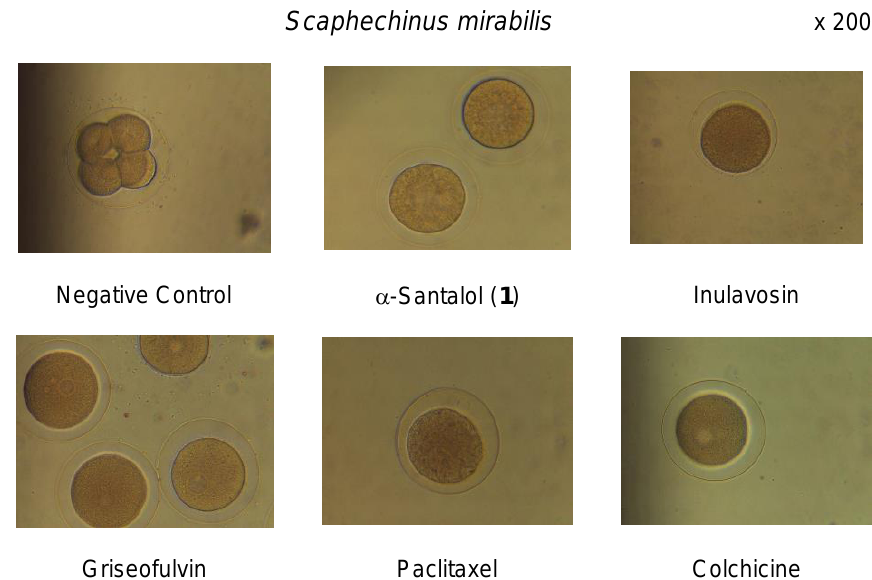
Figure 3. Antimitotic activity of α-santalol ( 1 ) and some natural products in sea urchin embryos.